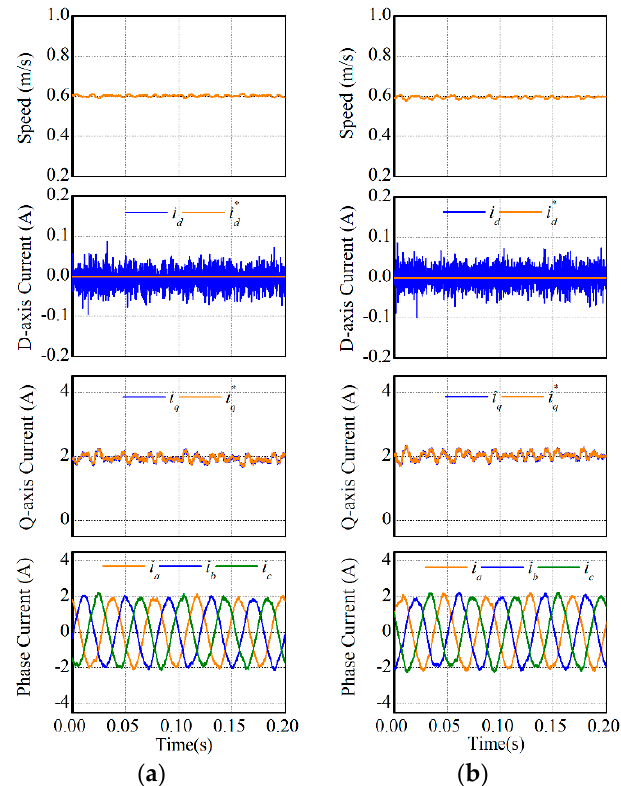
Figure 8. Steady-state performances under 0.6 m/s: ( a ) MPCC-I and ( b ) MPCC-II.